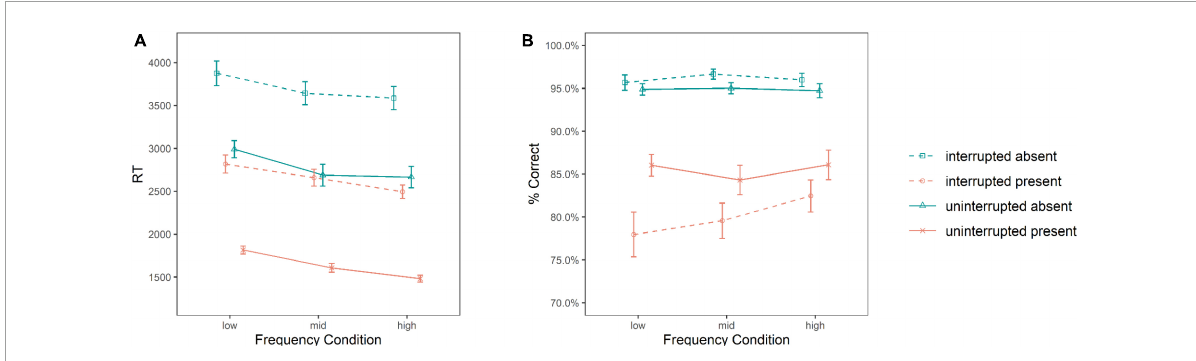
FIGURE2 Results for mean overall response times [RT, (A) ] and mean accuracy [% correct, (B) ] for the main visual search task as a function of frequency condition, target presence, and interruptions. Error bars present the standard error of the